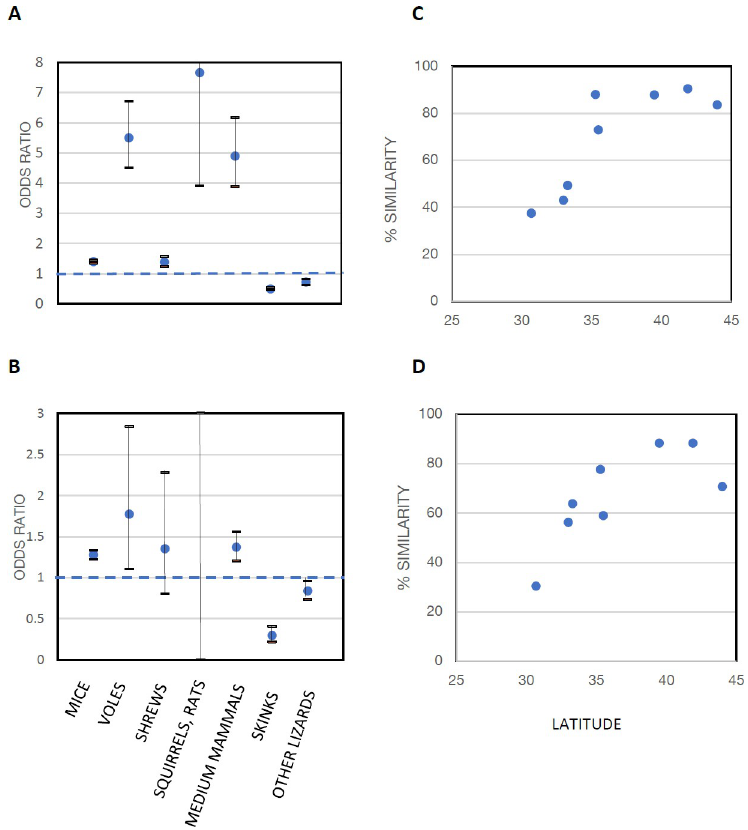
Fig 4. Latitudinal trends in tick–host associations. ( A, B ) Logistic regression of changes in proportion of (A) larvae and (B) nymphs from hosts in each category with latitude. Points are odds ratios with 95% Wald confidence limits. ( C, D ) Latitudinal patterns of percent similarity of distributions of individual animals sampled from each host category with distributions of (C) larvae and (D) nymphs collected from hosts in those categories. Data for Fig 4A and 4B are available in S6 Data. Data for Fig 4C and 4D are available in S7